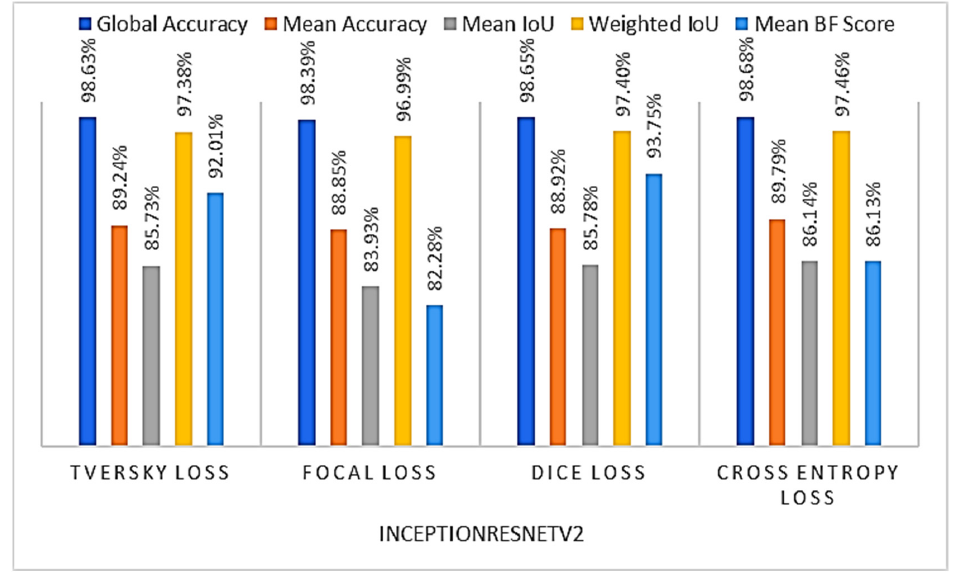
Figure 8. The overall metrics were gathered using different loss functions with Deeplabv3+ with ResNet-18 as a backbone. ResNet-18 as a